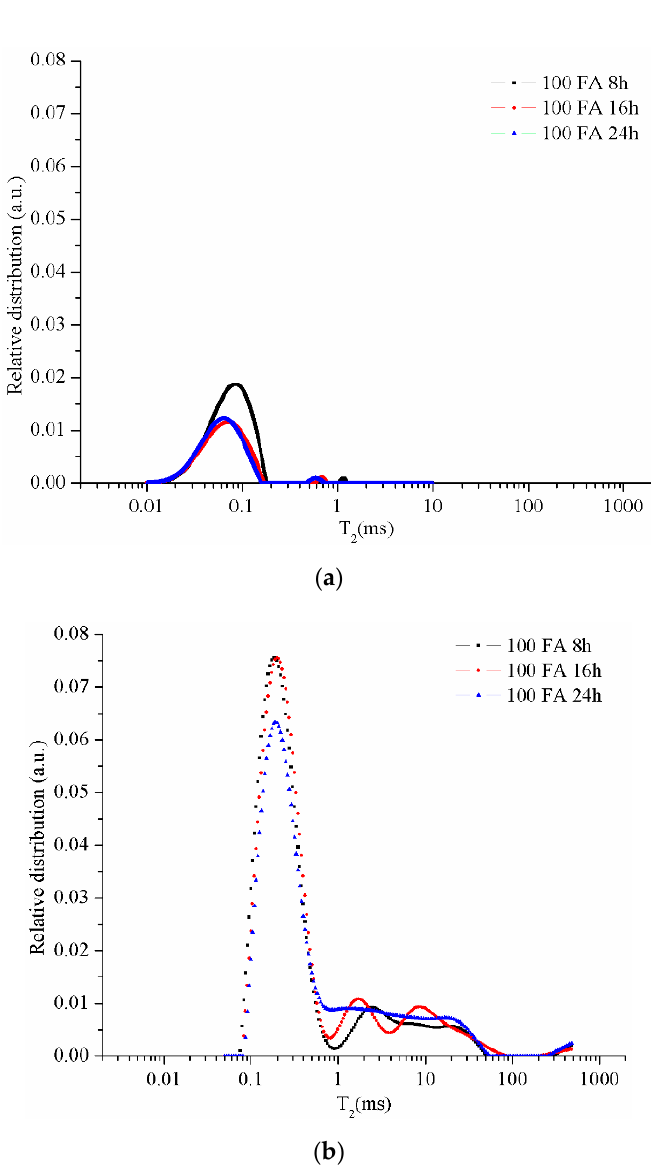
Figure 6. Relative pore size distribution in sample 100 FA dried for 8, 16, or 24 h: ( a ) after 48 days of activation and ( b ) after 7 days of immersion in water.